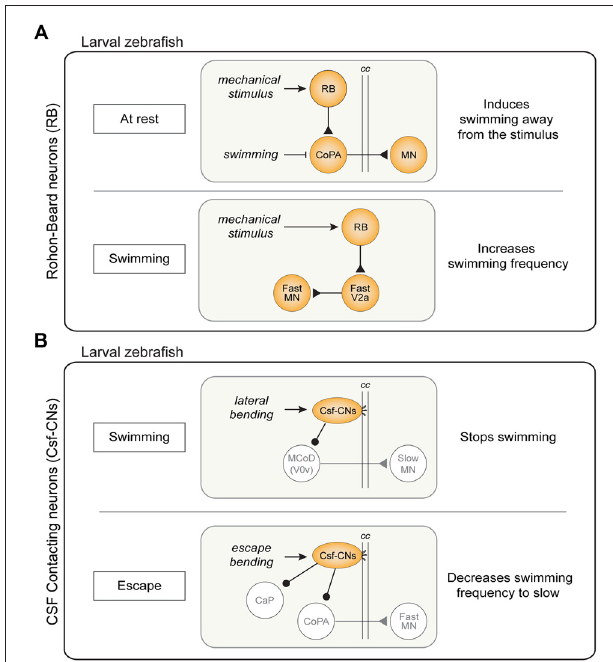
FIGURE 5 | Sensory modulation of swimming and escape circuits in larval zebrafish. (A) Pathways of Rohon-Beard (RB) neurons activity. Top: disynaptic cutaneous skin reflex. When the fish is at rest, an activation of RB sensory neurons results in swimming away from the stimulus through the excitation of commissural primary ascending (CoPA) INs. This mechanism is inhibited by during ongoing swimming. Bottom: during swimming, activation of RB sensory neurons act on the fast system increasing swimming frequency through the excitation of dorsal V2a INs. (B) Cerebrospinal fluid-contacting neurons (CSF-CNs) activity pathways. Top: lateral bending of the spinal cord during swimming activates CSF-CNs which respond inhibiting the MCoD (V0v) INs therefore stopping locomotion. Bottom: CSF-CNs are activated during escape behavior and act on the fast system inhibiting caudal primary MNs (CaP) and the CoPA INs, decreasing the swimming frequency. cc: central